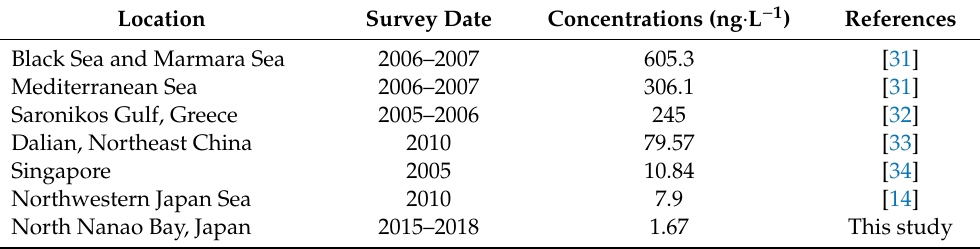
Table 1. Total concentrations of 13 PAHs (ng∙L −1 ) in surface seawater from different locations [14,30–34].